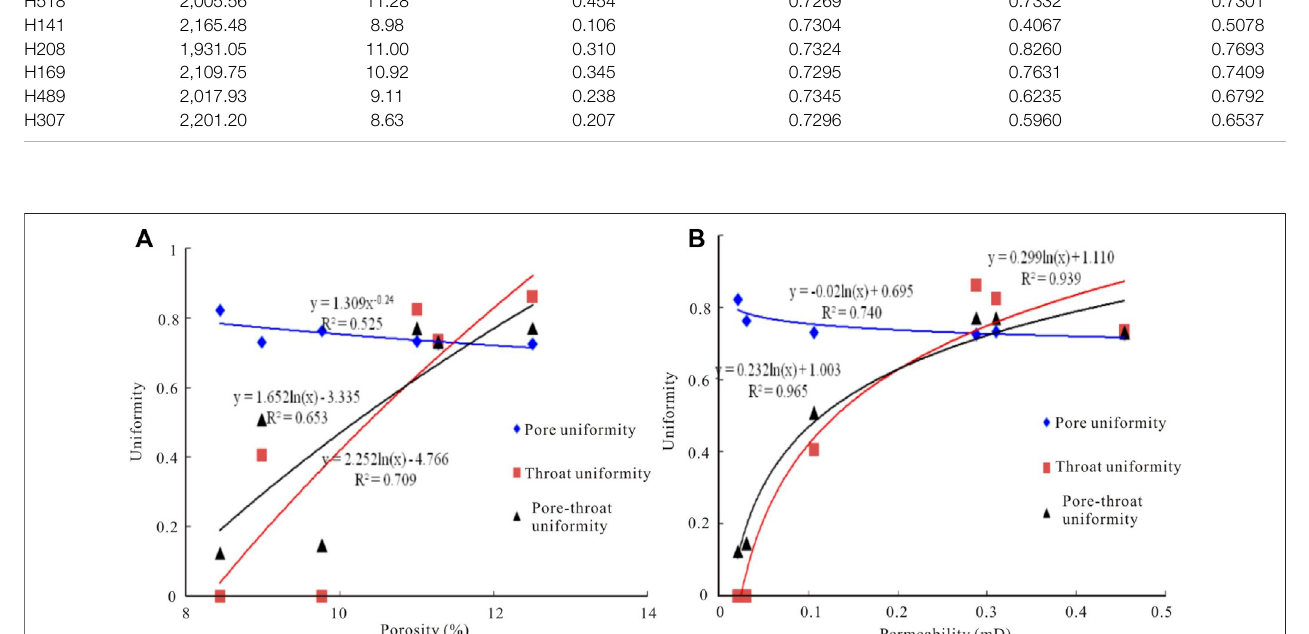
FIGURE 7 | Relationship between reservoir physical parameters and uniformity of pores and throats. (A) Relationship between porosity and uniformity; (B) Relationship between permeability and uniformity.